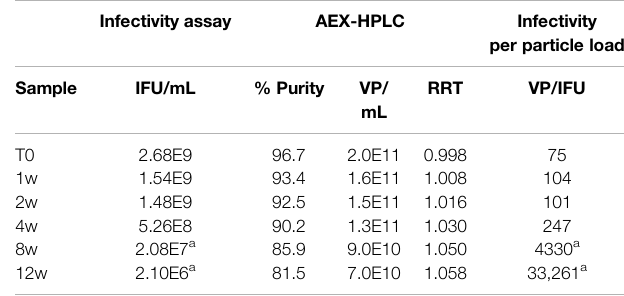
TABLE 2 | Infectivity & AEX-HPLC data from the AdC68 #2 accelerated stability time per particle load